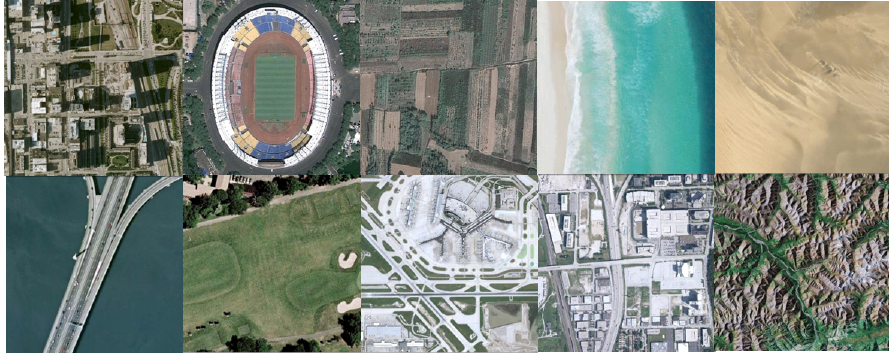
Figure 9. Samples of the WHU-RS19